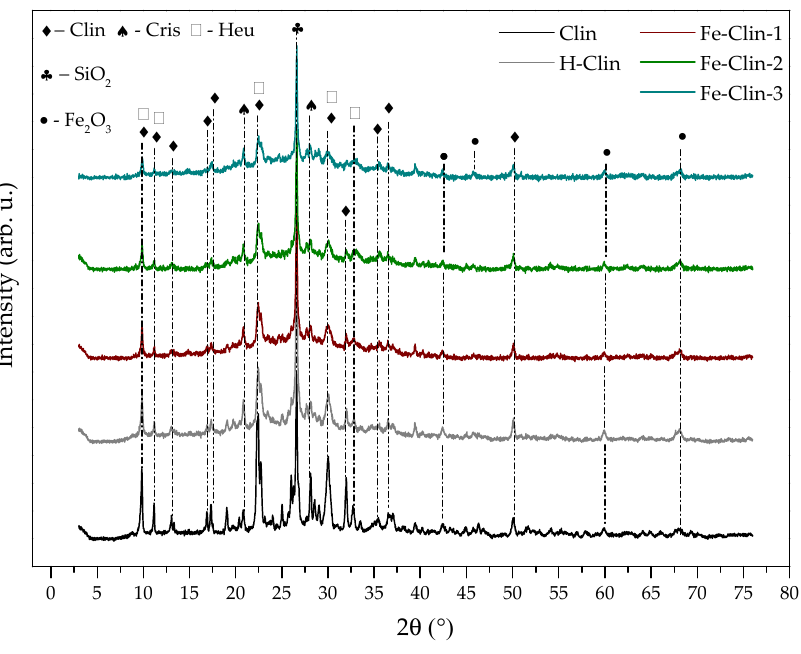
Figure 1. XRD patterns obtained for raw clinoptilolite (Clin), protonated clinoptilolite (H-Clin), and clinoptilolite modified with iron (Fe-Clin-1, Fe-Clin-2, Fe-Clin-3).